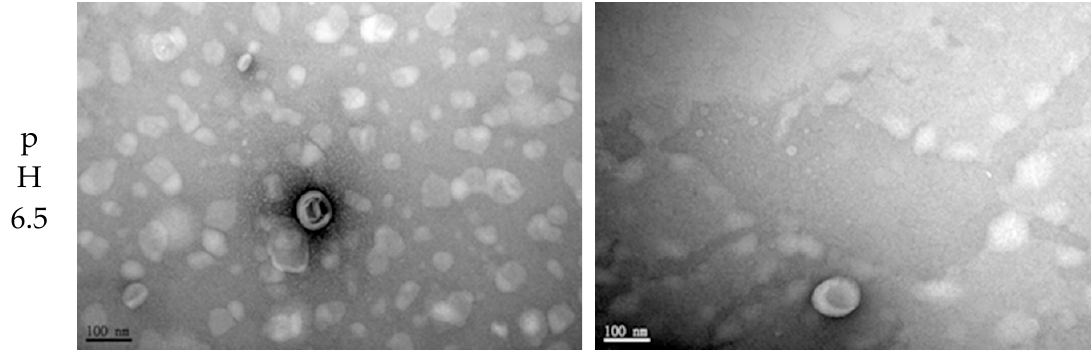
Figure 2. TEM images of IMQ-containing liposomes in different pH environments.